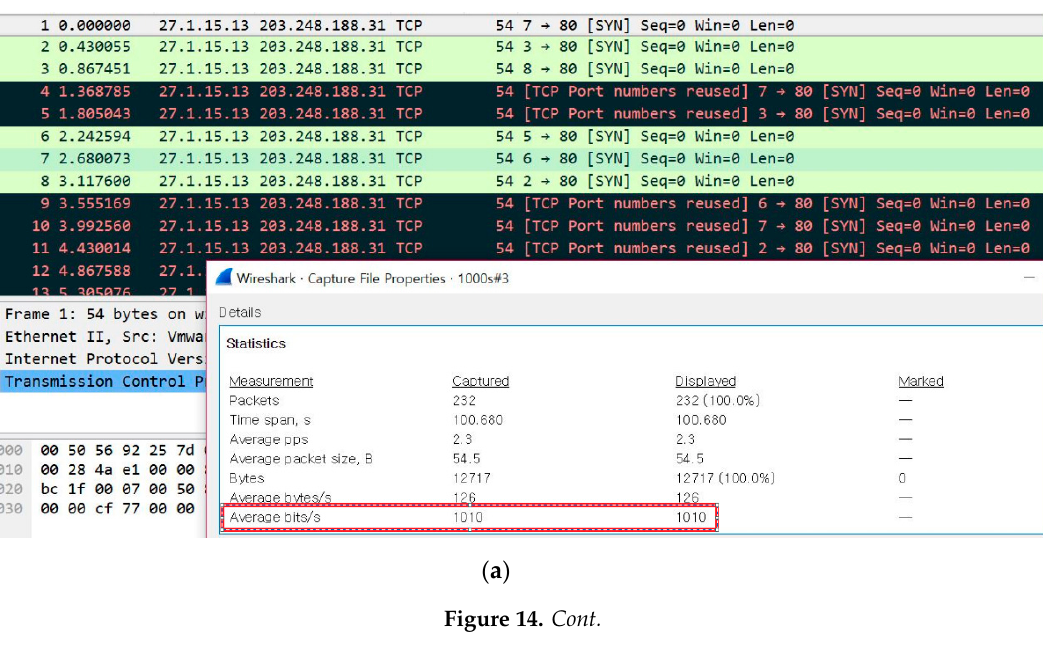
Figure 13. This is numbers of infected hosts: ( a ) total number of bots in real-world network of Figure 11; ( b ) total number of infected hosts in the proposed analysis system of Figure 12.